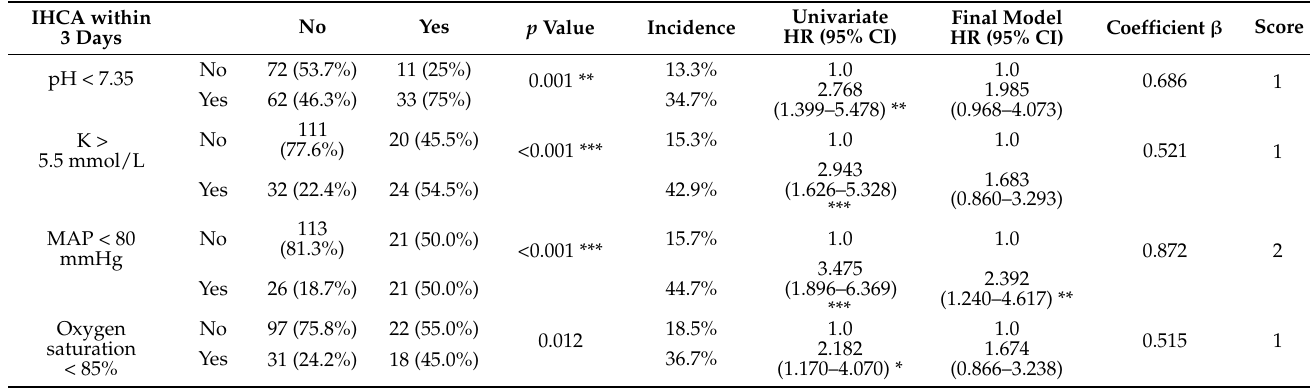
Table 4. Establishment of the scoring system after rounding and dividing β coefficients from the final model from significant variables in each domain.